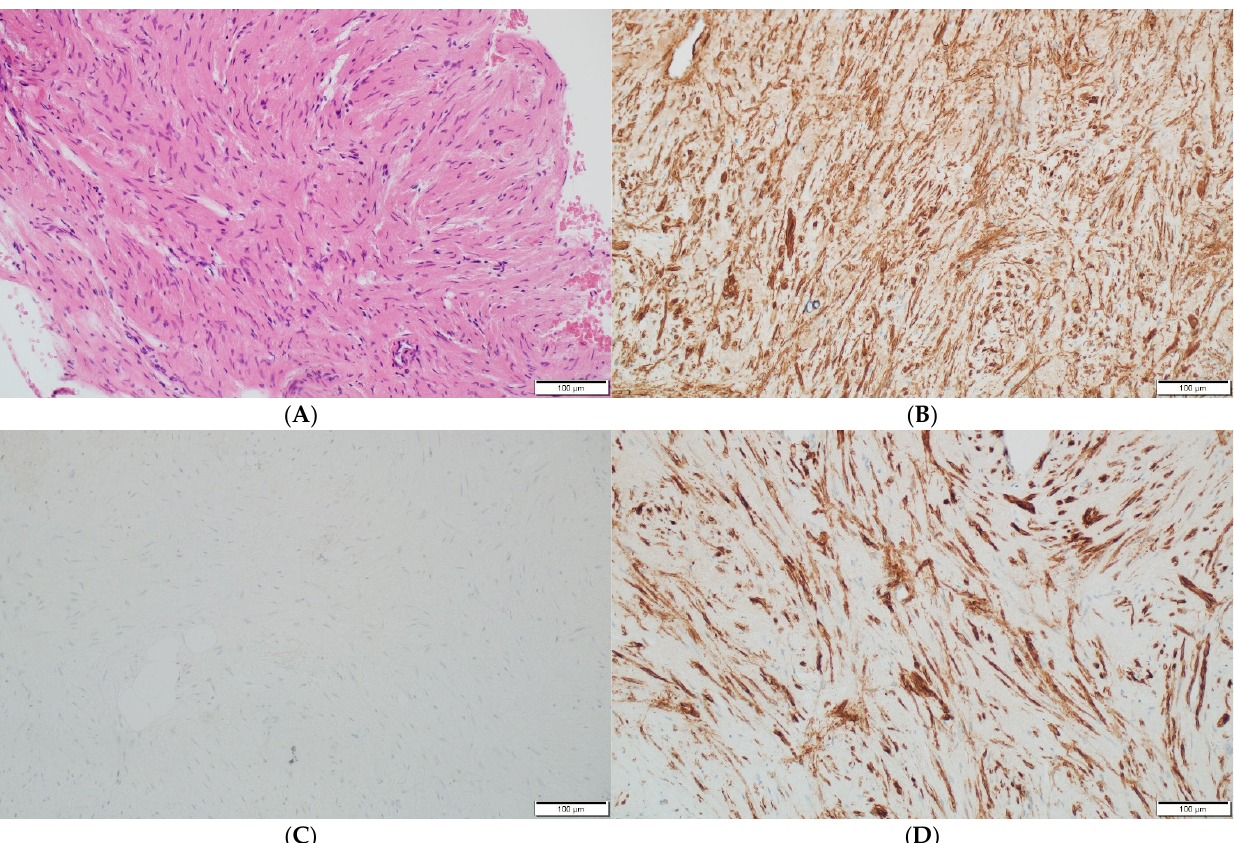
Figure 3. ( A ) The leiomyoma is composed of cells with elongated nuclei without cellular atypia (hematoxylin and eosin staining at a magnification of ×40 and ×200). ( B ) The immunohistochemistry for h-Caldesmon, which is positive in the leiomyoma cells (at a magnification of ×200). ( C ) The immunohistochemical staining for nuclear marker beta-catenin, which is negative in the leiomyoma cells (at a magnification of ×200). ( D ) The immunohistochemistry for smooth muscle antigen (SMA), which shows reactivity (at a magnification of ×200).